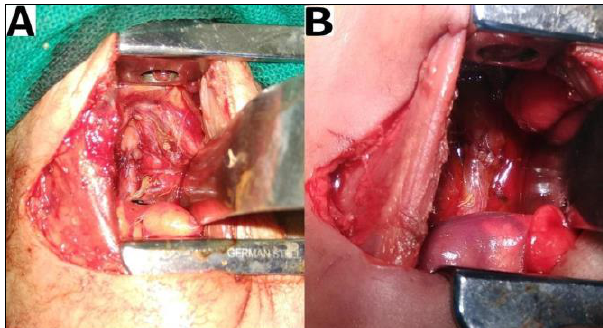
Figure 2: Intraoperative photographs showing: (A, B) end to end esophageal anastomosis with completely spared latissimus dorsi and serratus anterior